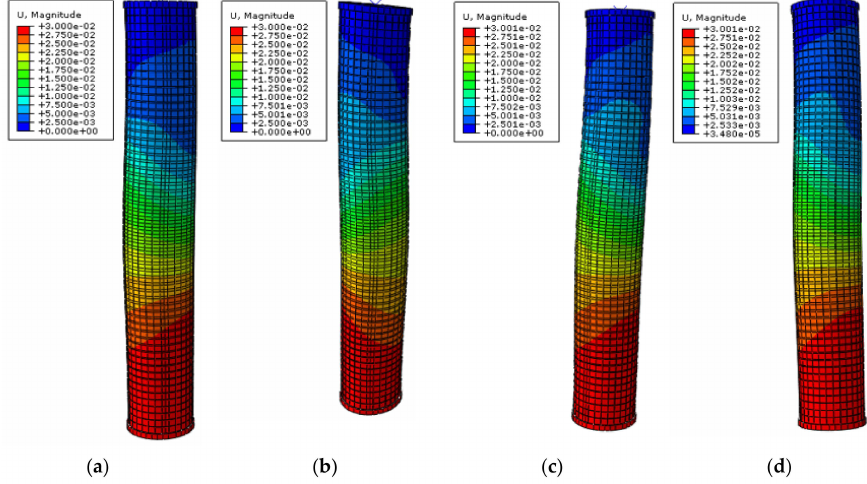
Figure 7. Contour of deflection for the CCSFT column with ( a ) 1 mm, ( b ) 2 mm, ( c ) 3 mm, and ( d ) 4 mm cross-shaped